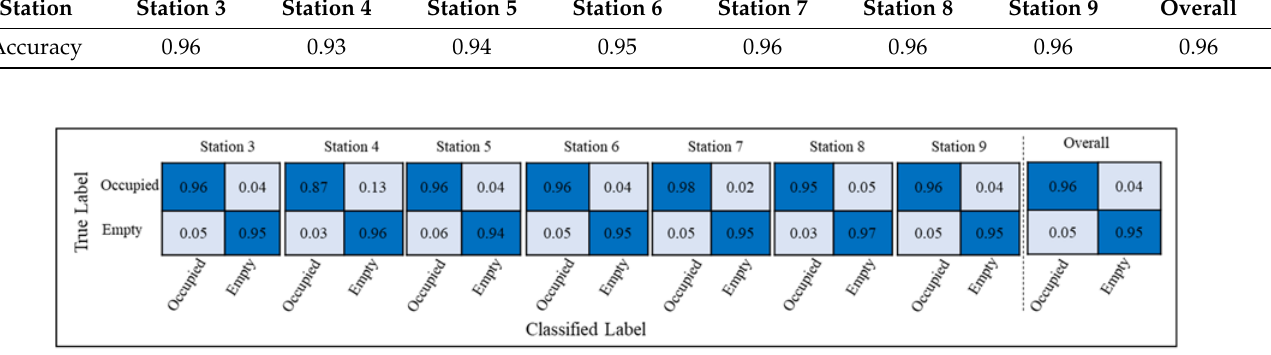
Figure 19. Overall and per-station confusion matrices.